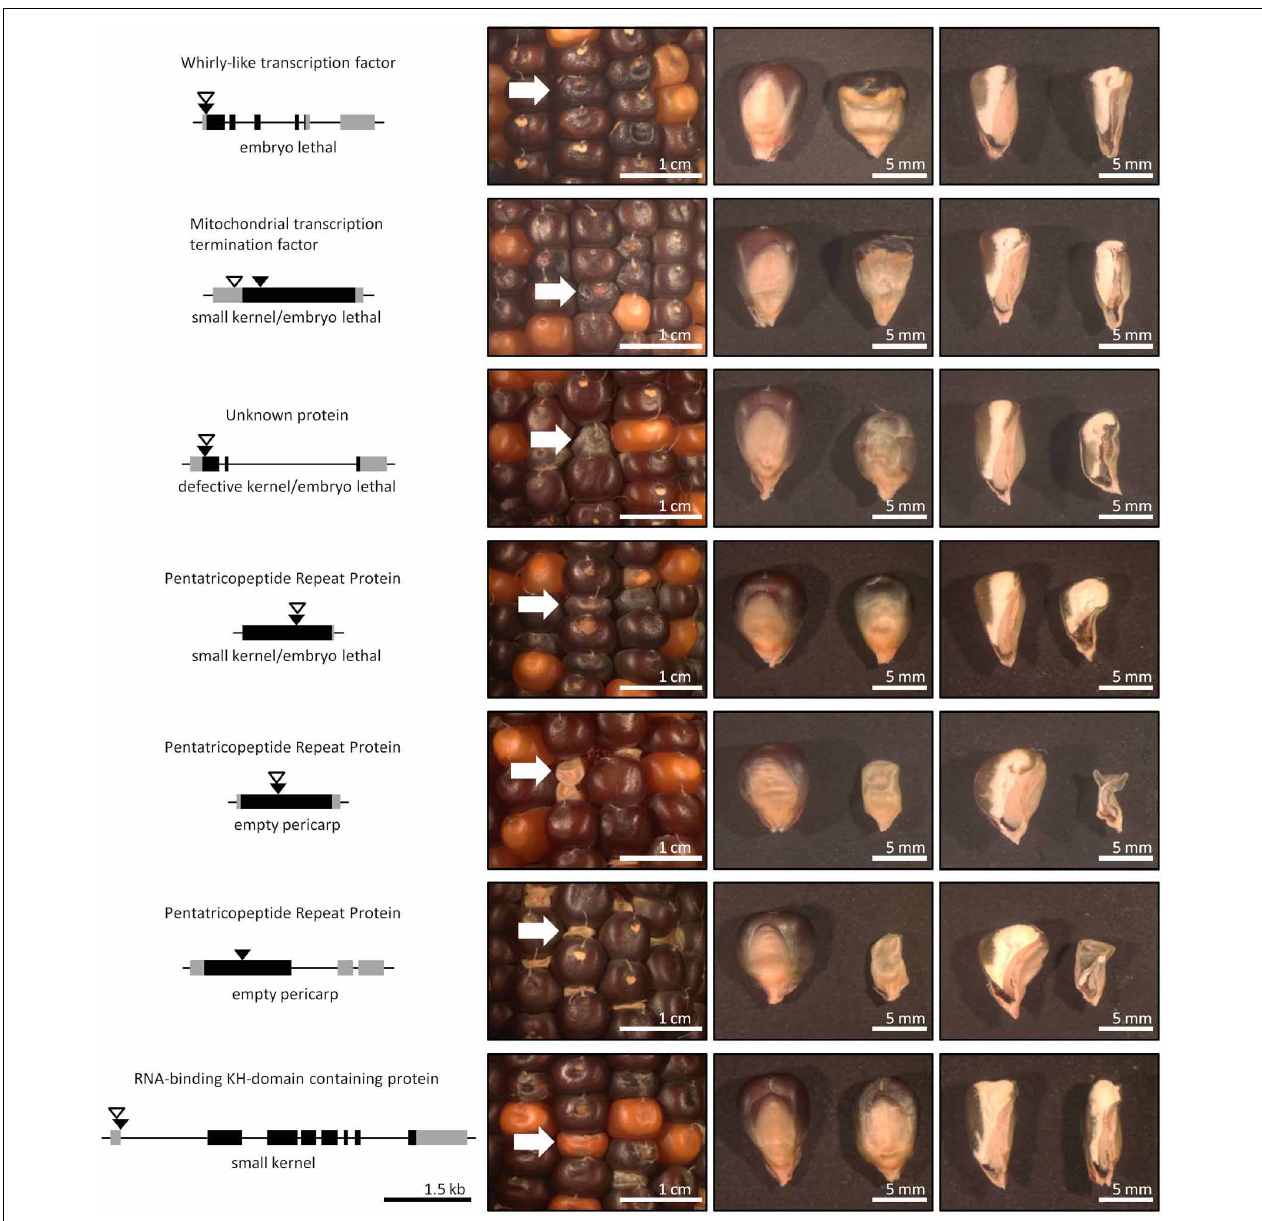
FIGURE 3 | Gene mutations that co-segregate with seed phenotypes. The seven, positive, co-segregation results from the forward-genetics Mu-seq grid corresponded to insertions in seven maize genes. The genes are diagrammed on the left, with Mu insertion sites identified in the sequencing grid indicated by black triangles, coding sequence by black bars, and untranslated regions by gray bars. Black-bordered, open triangles indicate positions of additional alleles available in other UniformMu lines. Six of the seven insertion sites were in exons, with the exception being an